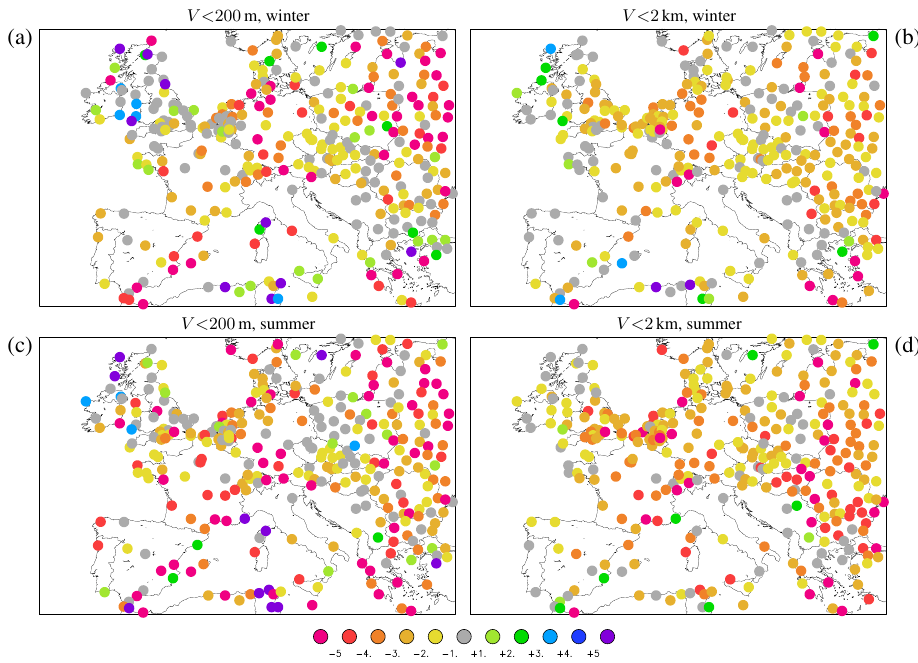
Fig. 2. Relative trend in low visibility [%/yr] over 1976–2006 in winter (a) and (b) October–March, and summer (c) and (d) April–September. In (a) and (c) the number of days with dense fog (visibility less than 200m) is shown, in (b) and (d) the number of days with visibility less than 2km.